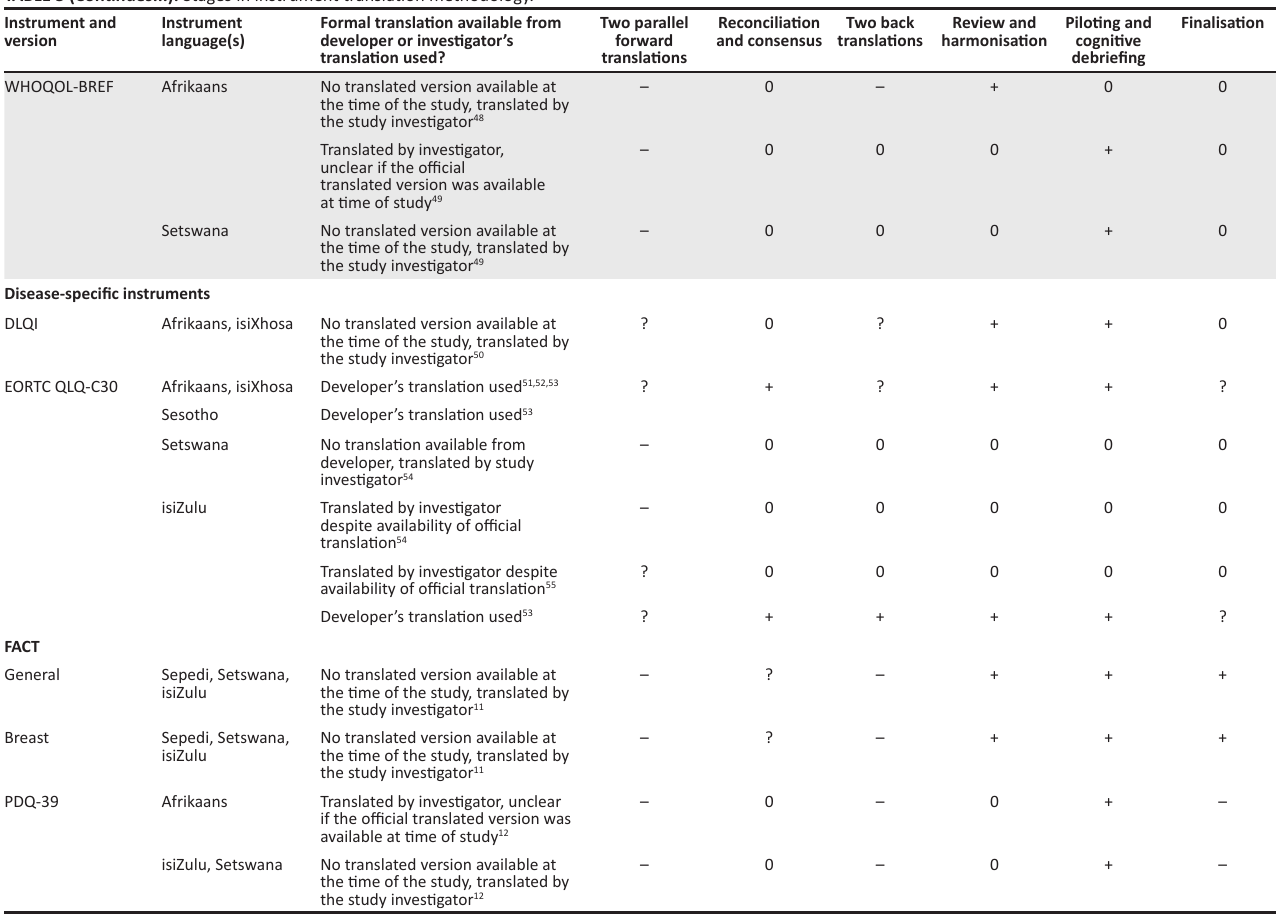
TABLE 3 (Continues...): Stages in instrument translation methodology. Instrument and Instrument version